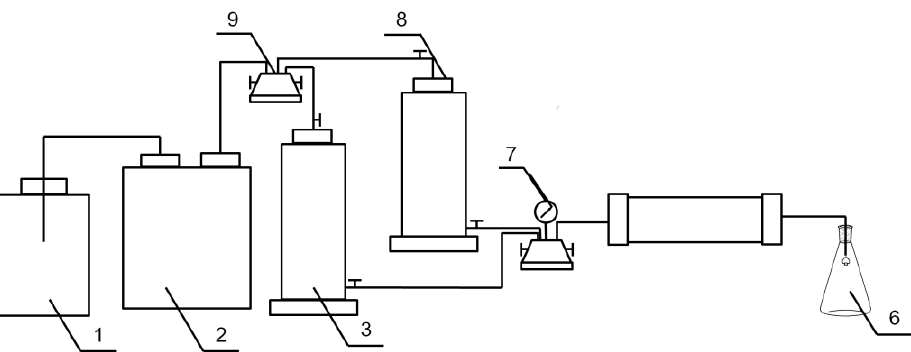
Figure 1. Schematic diagram of the experimental setup for tracer transport in cores: 1: Driving fluid pump; 2: constant flux pump; 3: tracer fluid tank; 4 and 9: six-way valves; 5: core holder; 6: collection flask; 7: pressure gauge; 8: formation water tank.